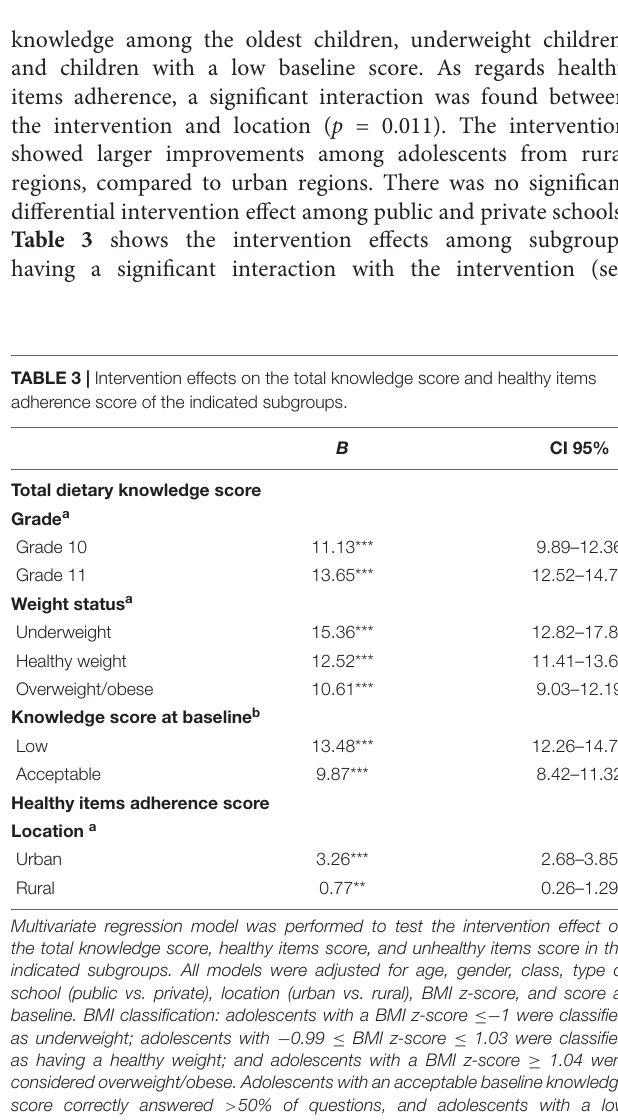
Multivariate regression model was performed to test the intervention effect on the total knowledge score, healthy items score, and unhealthy items score in the indicated subgroups. All models were adjusted for age, gender, class, type of school (public vs. private), location (urban vs. rural), BMI z-score, and score at baseline. BMI classification: adolescents with a BMI z-score ≤− 1 were classified as underweight; adolescents with − 0.99 ≤ BMI z-score ≤ 1.03 were classified as having a healthy weight; and adolescents with a BMI z-score ≥ 1.04 were consideredoverweight/obese.Adolescentswithanacceptablebaselineknowledge score correctly answered > 50% of questions, and adolescents with a low baseline knowledge score had < 50% of correct answers. The interaction between background variables and the intervention variable was found to be significantly associated with the dependent variables (i.e., knowledge score and healthy items score) with a p < 0.05 and b p < 0.001; CI, confidence interval; **p < 0.01; ***p <